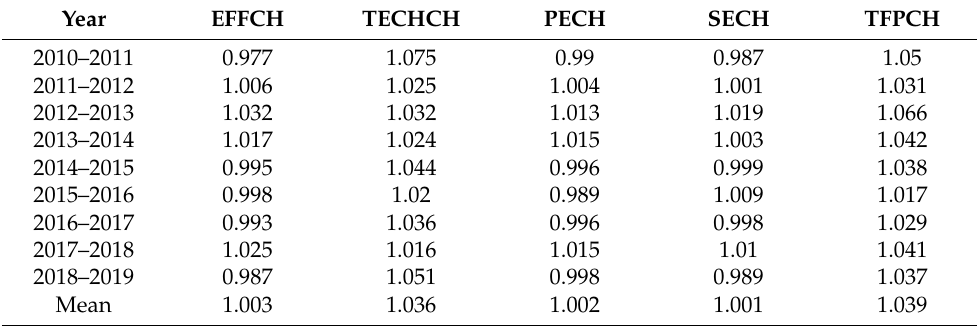
Table 5. Evaluation of adjusted APE in the YREB from 2010 to 2019.